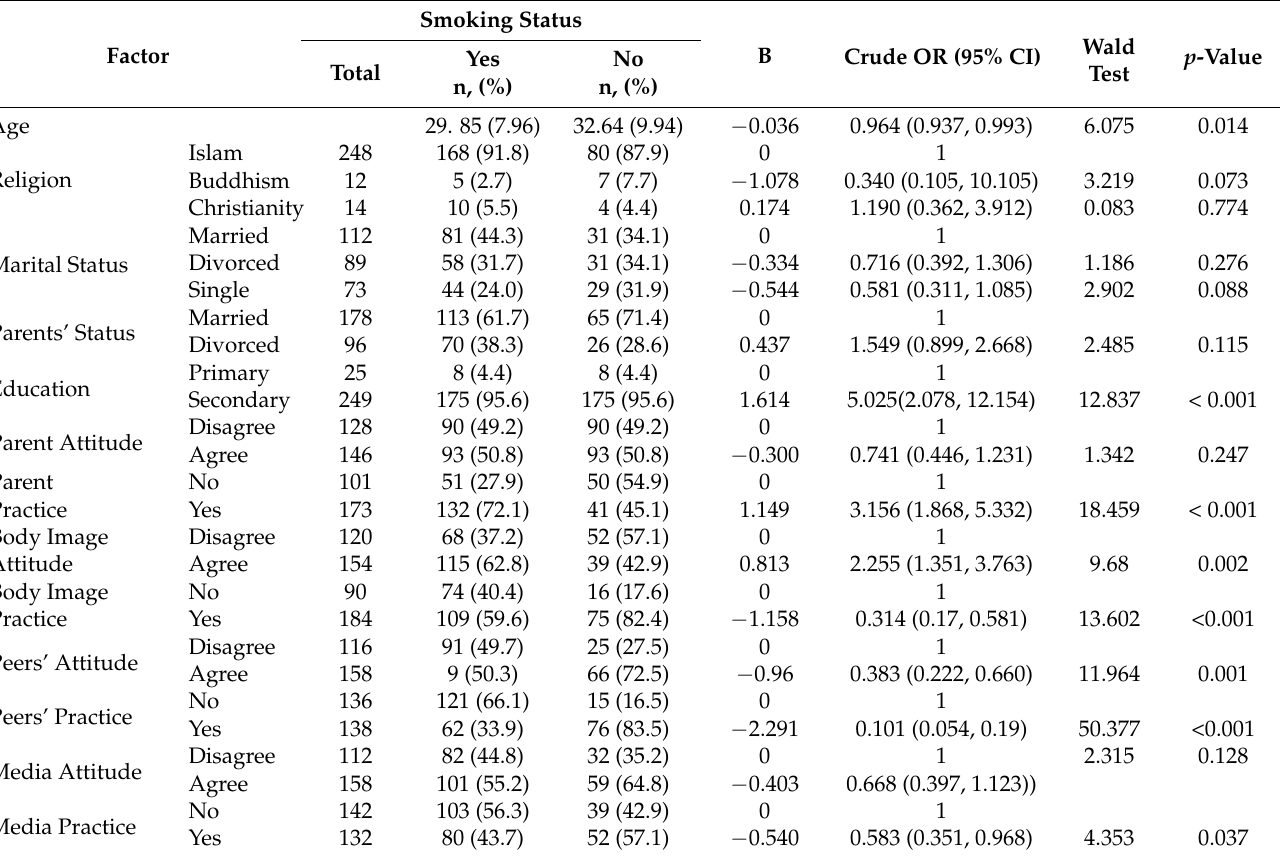
Table 3. Summary of associated factors of smoking among women inmates in Kelantan (Univariate Analysis) (n = 274).